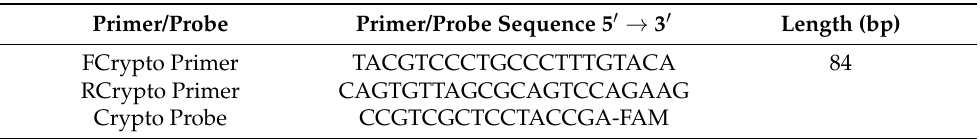
Table 1. Specific primers and probes (TaqMan assay) to target SSU-rDNA gene from C. irritans for quantitative PCR and droplet digital